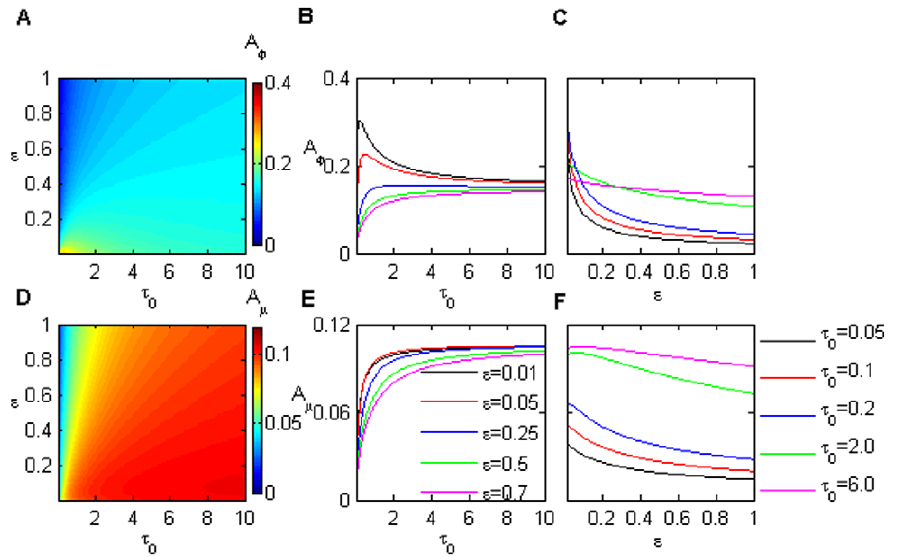
Figure 7. The role of the noise autocorrelation time t 0 and the time scale of the protein reaction e on noise amplification. The noise amplification in (A) the protein module and (D) miRNAs as a function of e and t 0 . The noise amplification evolutes with t 0 in input signal for various e (B, E), and e for different t 0 (C, F) for protein and miRNA modules, respectively. The parameter values are a ~ 0 : 15 , c 1 ~ 1 : 0 , c 2 ~ 1 : 3 , k ~ 4 : 5 .